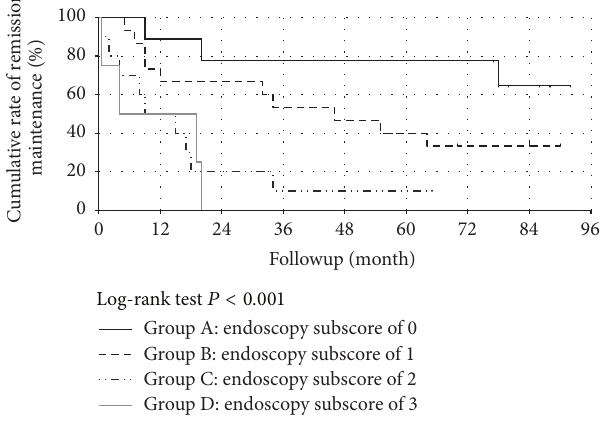
Figure 2: Cumulative rates of remission maintenance according to Mayo endoscopic